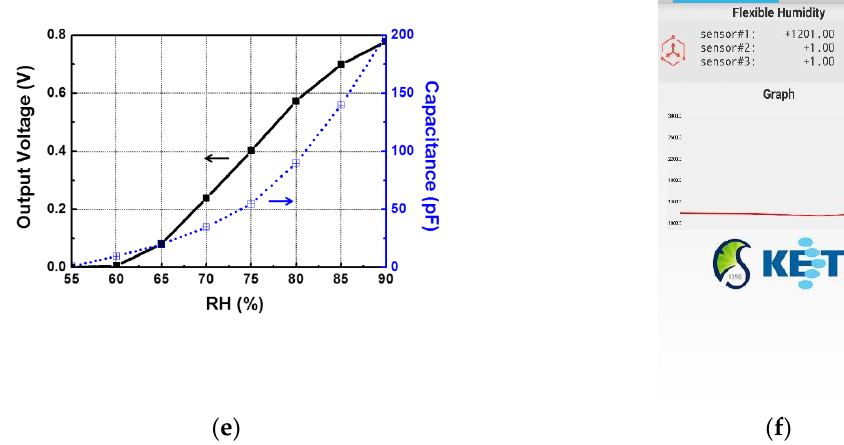
Figure 4. ( a ) Real image of the flexible PI-based plant drought sensor attached on the lower surface of leaves; ( b ) Nicotiana tabacum responses to drought stress over time. Inset: schematic 3D images of stoma responses under: normal conditions (a blue arrow) and drought conditions (a red arrow); ( c ) real image of a Bluetooth (BLE) and real-time monitoring system integrated with a PI-based plant drought stress sensor; ( d ) schematic of a read-out interface circuit and ( e ) the measured output voltage according to humidity; ( f ) a mobile application for plant drought monitoring.